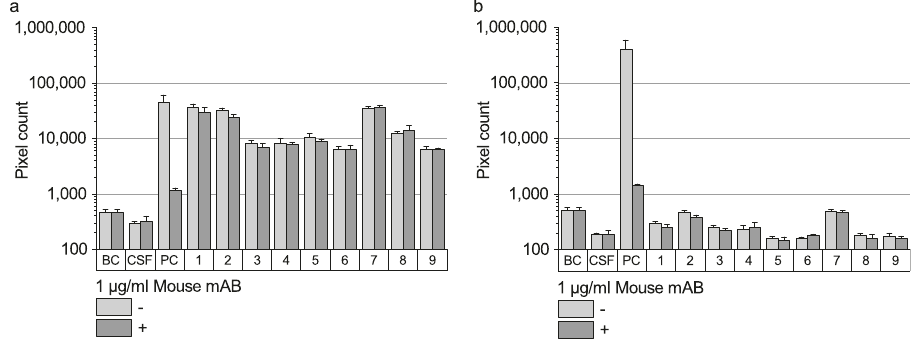
Fig. 8 In fl uence of heterophilic anti-mouse antibodies. To test, if the signal obtained by sFIDA was possibly caused by heterophilic anti- mouse antibodies, nine CSF samples were incubated with or without 1 µg/ml MOPC-21. As a HAMA model and positive control (PC), we used a goat anti-mouse antibody. The interference of this anti-mouse antibody was reduced by about 98.4% for aSyn (211 CF633, a ) and 99.7% for Tau (Tau5 CF488, b ) when adding MOPC-21 while for the CSF samples the signal remains unaffected. Standard deviation was calculated from the four